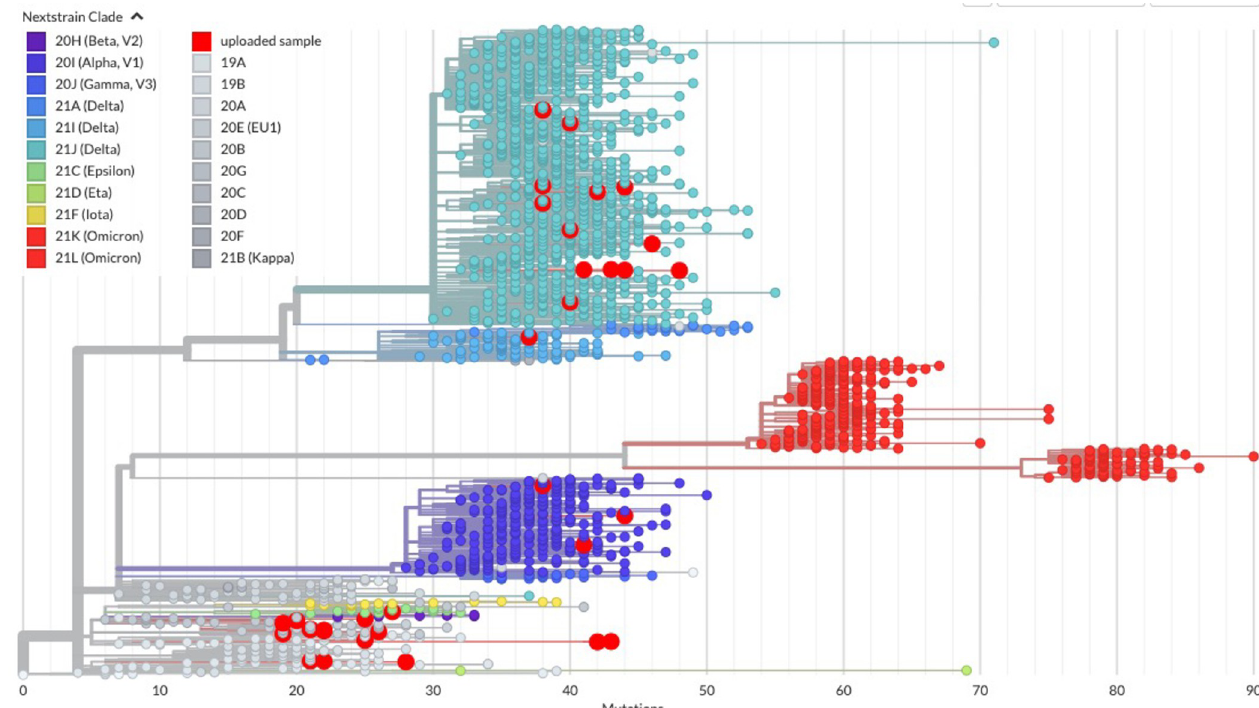
Fig 7. Samples placed into global phylogeny. Consensus sequences for each sample were analyzed by UShER [21] and placed into a global phylogenetic tree sorted by Nextstrain clade. Large red circles indicate uploaded samples for this dataset.